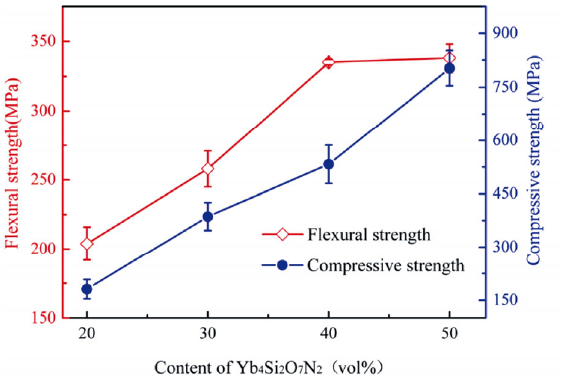
Fig. 4 Flexural strength and compressive strength of h -BN/Yb 4 Si 2 O 7 N 2 composites.